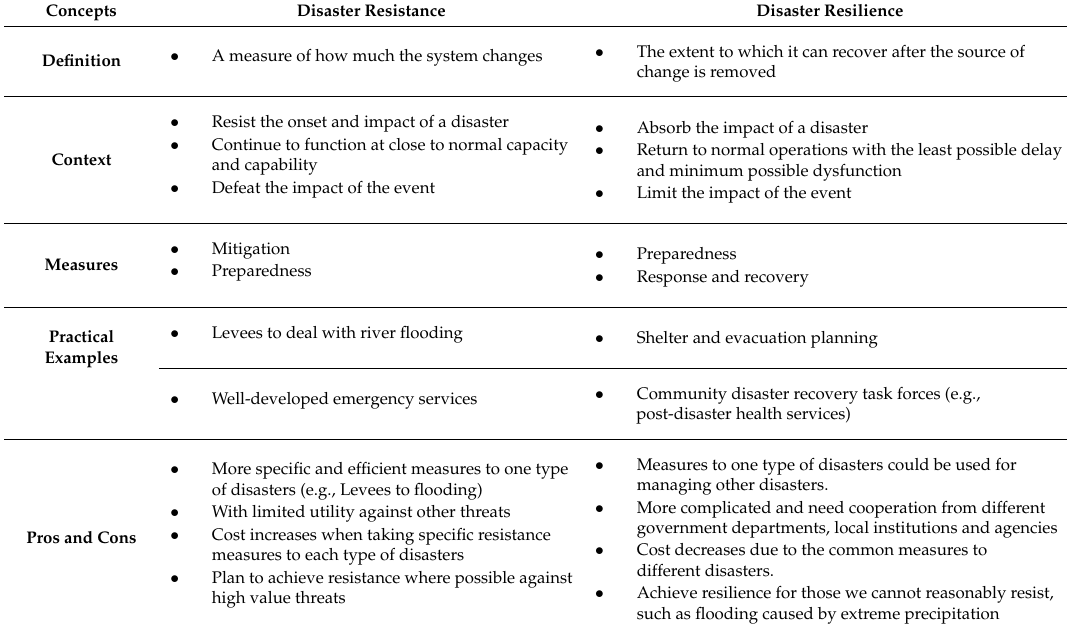
Table A1. Comparison between disaster resistance and disaster